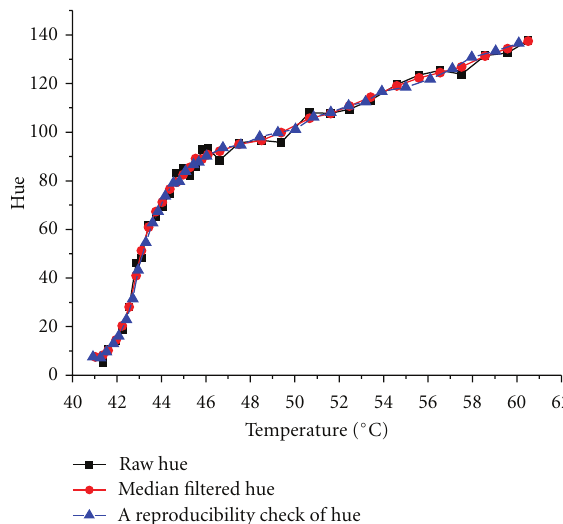
Figure 4: E ff ect of the lighting angle on the hue curve of the TLC